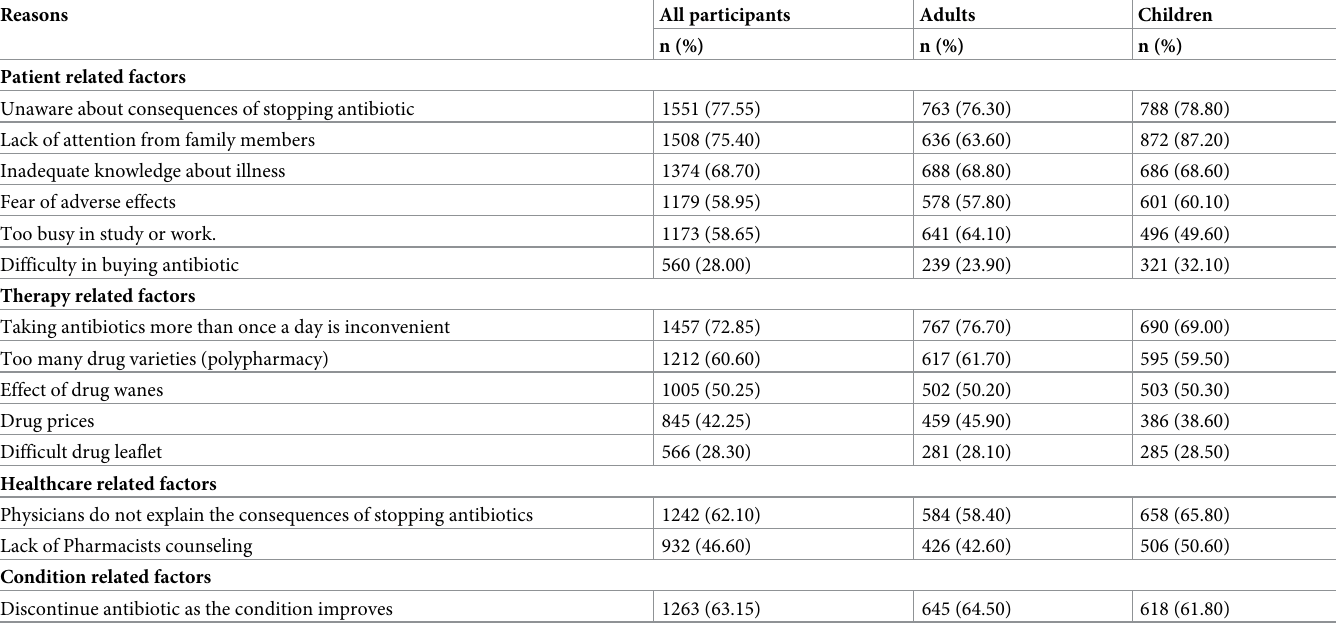
Table 4. Reasons of non-adherence to antibiotics as reported by all